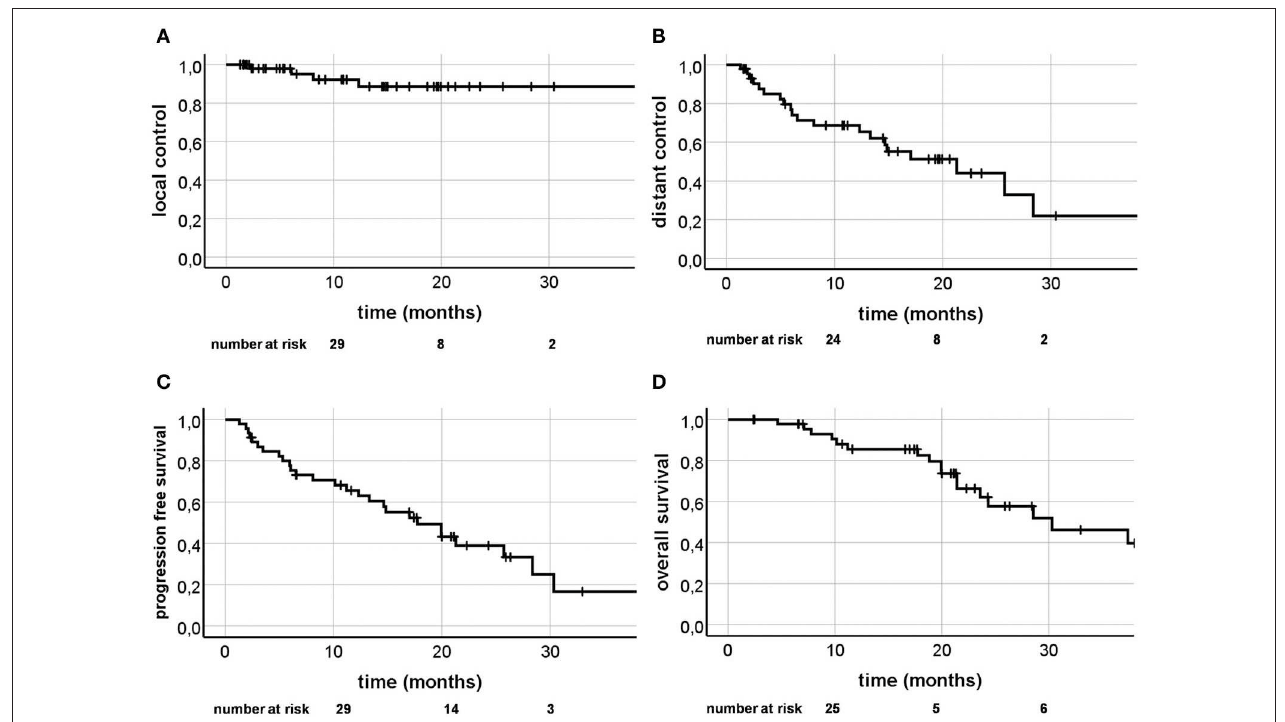
FIGURE 2 | Kaplan-Meier curves; Local control (A) , distant control (B) , progression free survival (C) , and overall survival (D) .